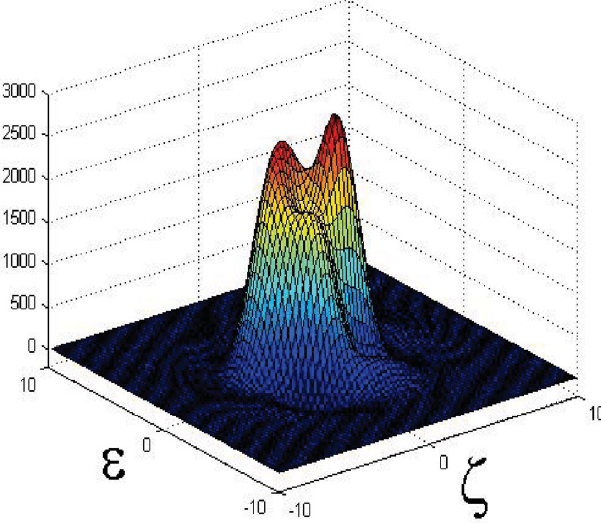
FIG. 8. (Color) Longitudinal phase-space reconstruction of the electron beam in giant pulse mode at turn